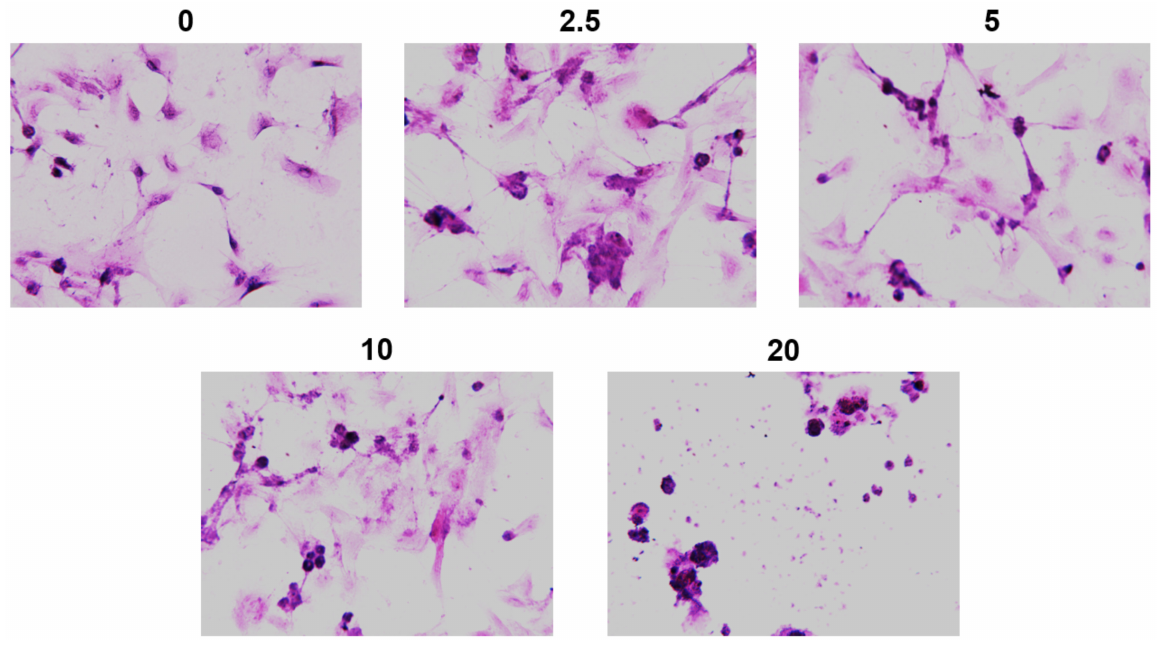
Figure 4. ZnO NP effects on cell morphology. Cells were exposed to 0, 2.5, 5, 10, and 20 µ g/cm 2 of ZnO NPs over 48 h. After treatment, cells were stained with hematoxylin–eosin (HE). Micropho- tographs were taken by an Olympus BX51 microscope at 20 × magnification.